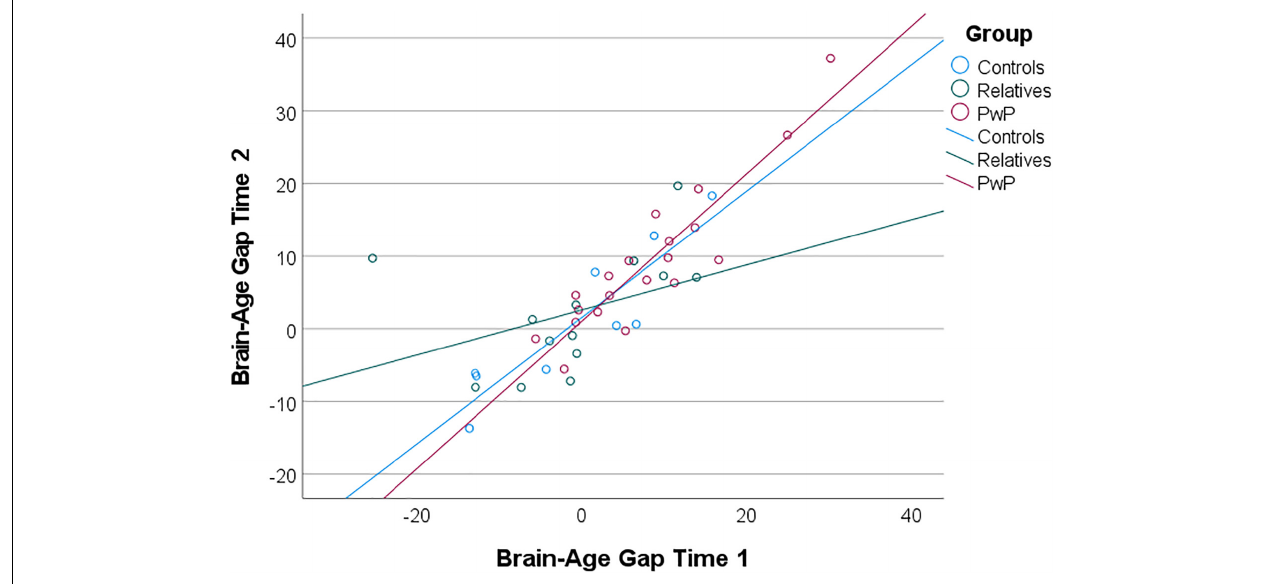
FIGURE 4 | Scatterplot of uncorrected brain-age gap scores from exploratory longitudinal analysis. Brain-age gap scores increased over time for all groups; groups did not differ in change in brain-age gap over time (i.e., brain-age